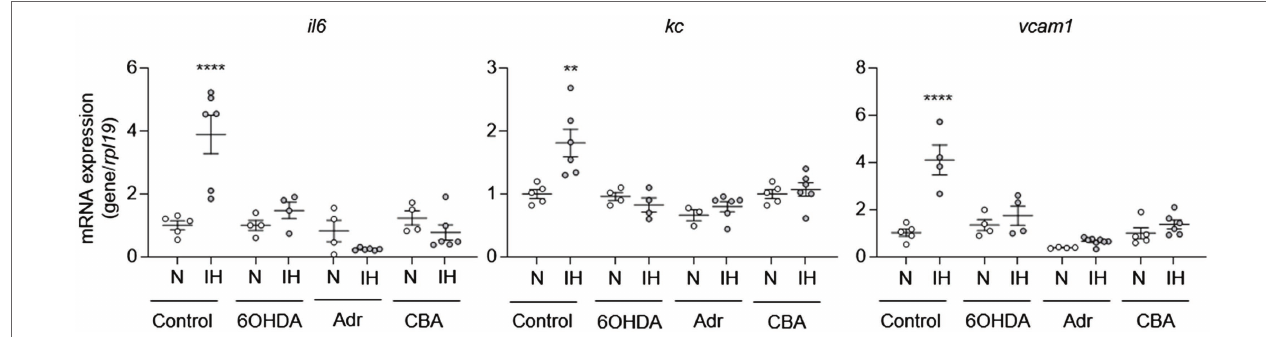
FIGURE 4 | Intermittent hypoxia-induced catecholamines are required for intermittent hypoxia-induced aortic EC activation in mice. We exposed C57BL/6 mice to normoxia (N) or IH for 10 days in the absence or presence of 6OHDA. We also exposed mice with adrenalectomy (Adr) and carotid body ablation (CBA) to IH for 10 days. We then assessed EC activation by measuring mRNA expression of markers of EC activation genes, including il6 , kc , and vcam1. N = 5–6. Significance was determined by one-way ANOVA using Bonferroni’s correction. ** p < 0.005; **** p < 0.0001.